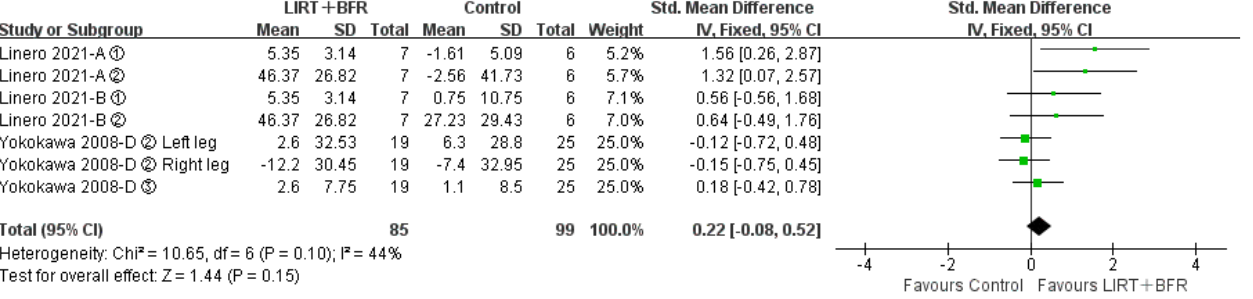
Figure 6. Meta-analysis of balance [20,29]. Figure Notes: A, LIRT + BFR VS Daily exercise; B, LIRT + BFR VS LIRT; D, LIRT + BFR VS Dynamic Balance Exercise. ① Static eyes closed(s); ② Static eyes open(s); ③ Balance functional reach test.